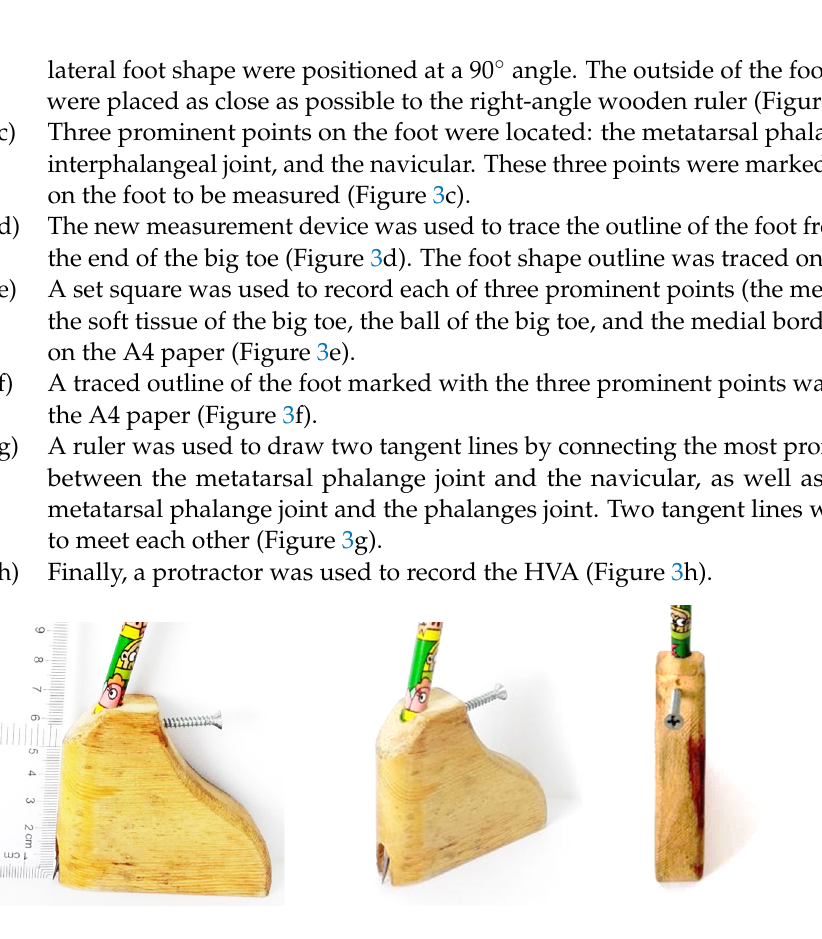
Figure 2. Design and characteristics of a newly designed measurement device.